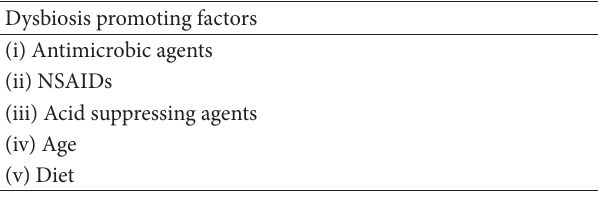
Table 1: This table shows the list of the main factors involved in the development of dysbiosis that promotes recurrent Clostridium difficile infection.